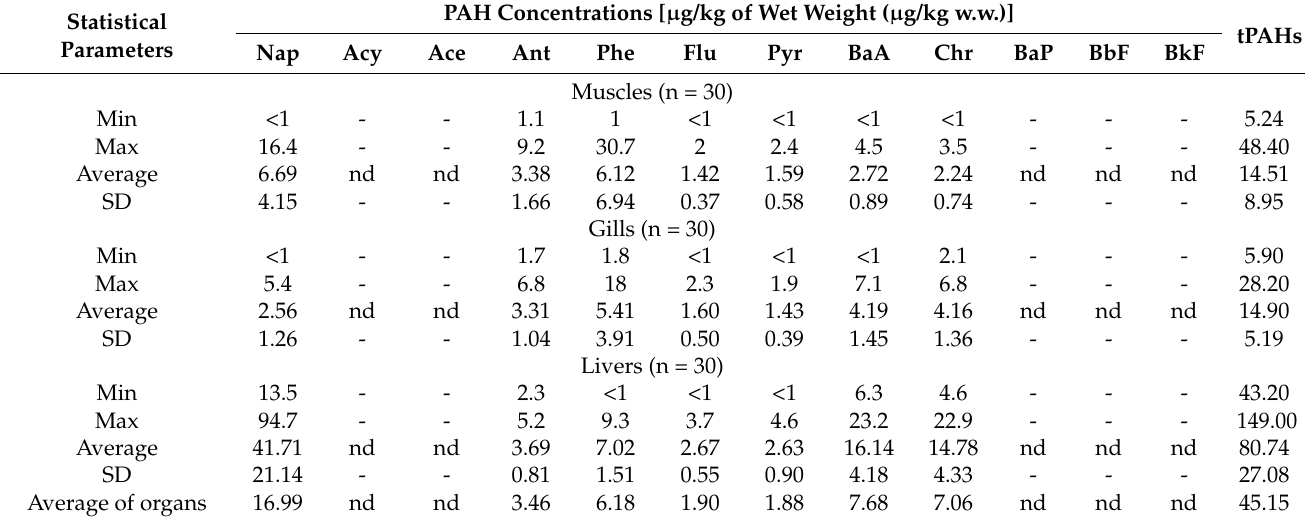
Table 2. Statistical parameters of polycyclic aromatic hydrocarbons contents in fish